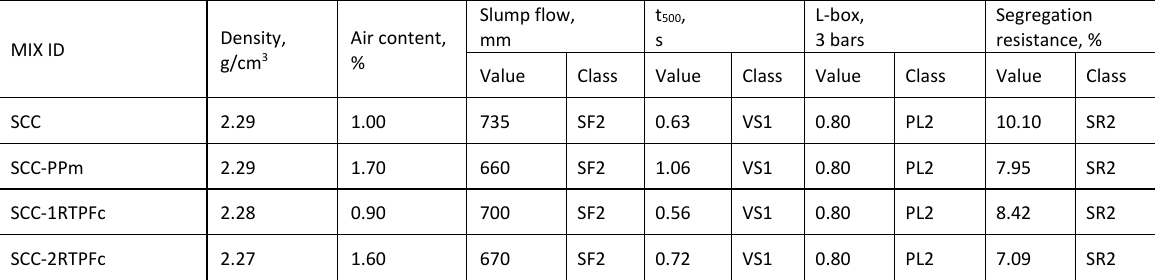
Table 5. Results of testing fresh concrete